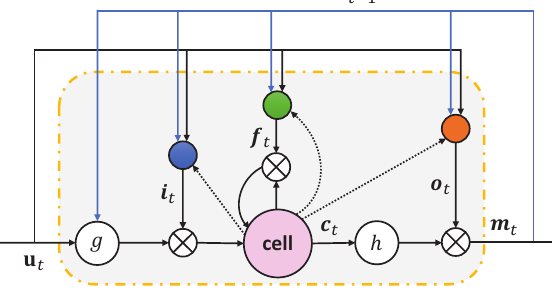
Figure 6. The configuration of LSTM memory